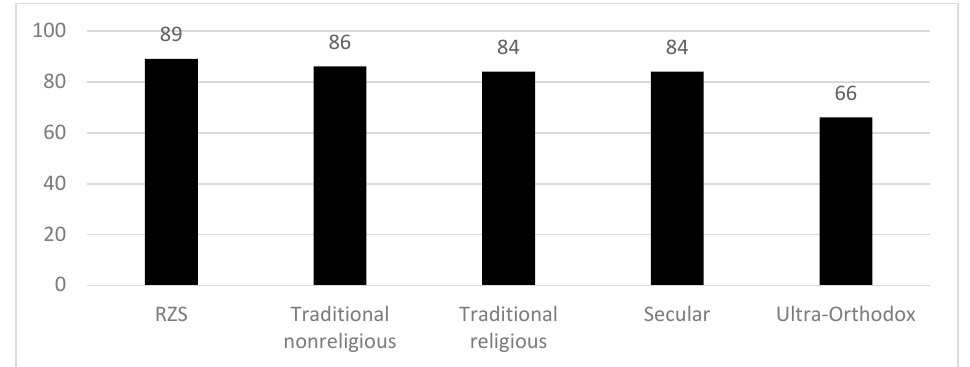
Figure 4. Feel part of the state of Israel and its problems, by level of religiosity (%) (Source: Israeli Democracy Index, 2014–2021).